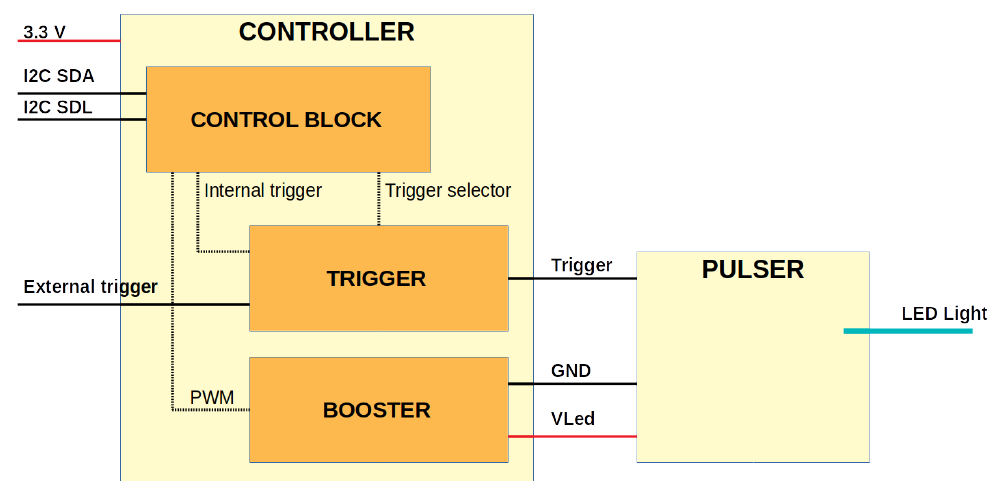
Figure 2. The architecture of NOPELED. The pulser board contains the switching electronics to make the LED flash. The control board includes the booster, where the variable voltage to supply the pulser is generated; the trigger block, where the internal or external trigger is selected; and the control block, where the internal trigger is generated, the trigger selection is controlled, as well where the PWM signal to control the booster voltage is created. The control block also implements communications via I 2